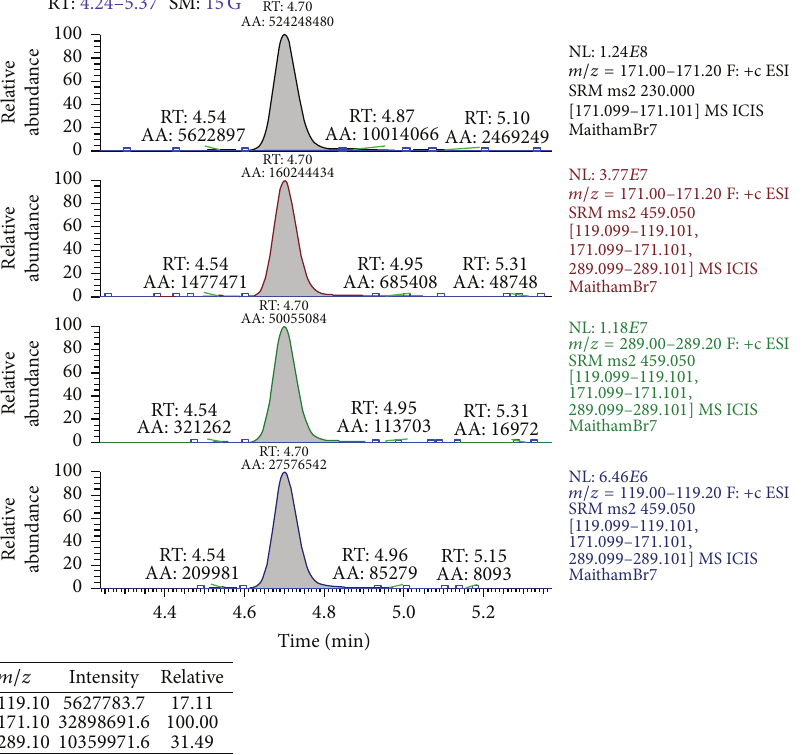
Figure 5: LC/MS/MS chromatography of L-BMAA level (33.6 𝜇 g/g) in male mouse brain tissue with a dose of 3 mg/g